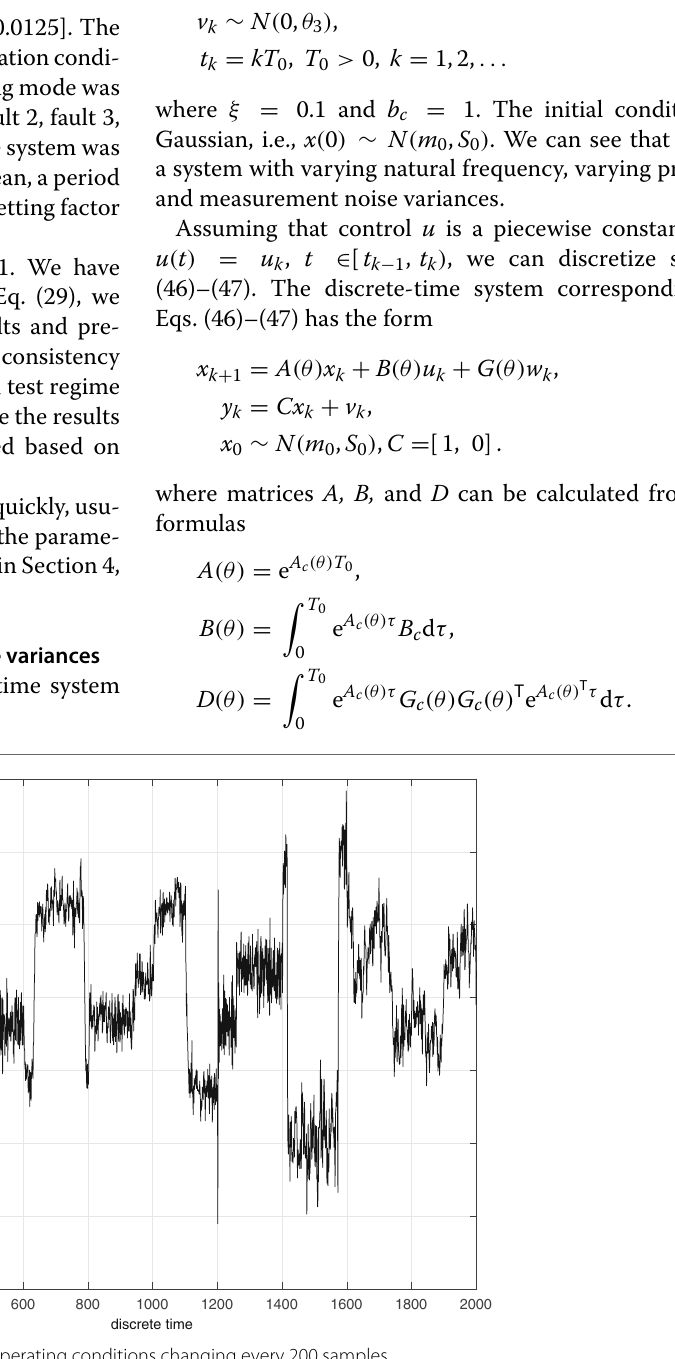
Fig. 1 Measured output signal for the system (45) with operating conditions changing every 200